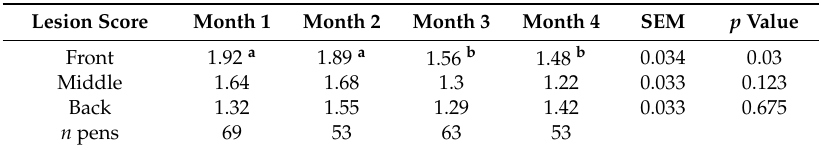
Table 2. Mean skin lesion scores (0–5) at the front, middle and back of the pigs related to month (age) with SEM and p value for 64 pens in total; different superscripts within a row indicate a statistical difference ( p < 0.05).